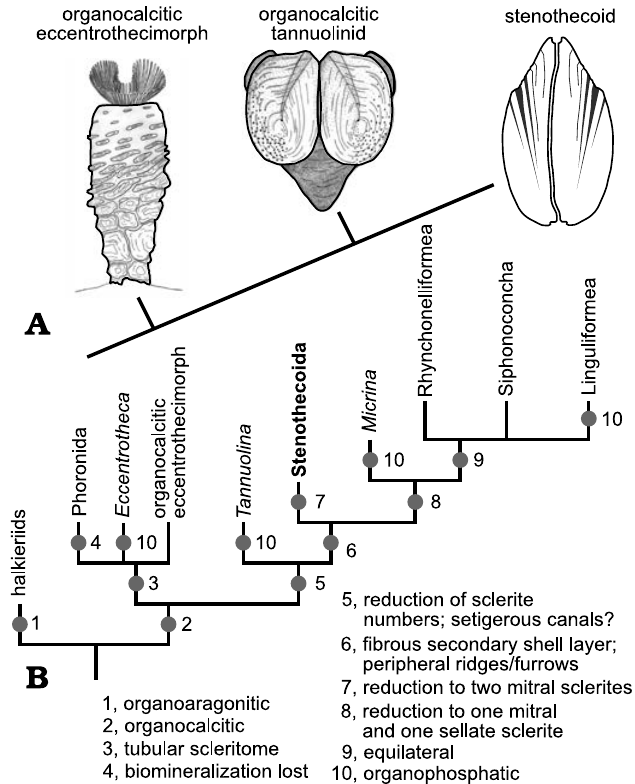
Fig. 14. A . Hypothesized morphogenetic pathway for derivation of the bivalved stenothecoid scleritome from a multisclerite, tubular, organocal- citic, eccentrothecimorph ancestor via a hypothetical organocalcitic tann- uolinid. Eccentrothecimorph slightly modified from Skovsted et al. (2011: text-fig. 17). Tannuolinid modified from Skovsted et al. (2014). B . A pos- sible cladogram that assumes an organocalcitic scleritome is primitive for the Pan-Brachiopoda. In this view, organophosphatic mineralogy evolved independently several times and the Stenothecoida evolved a bivalved scleritome independently of the Brachiopoda + Micrina